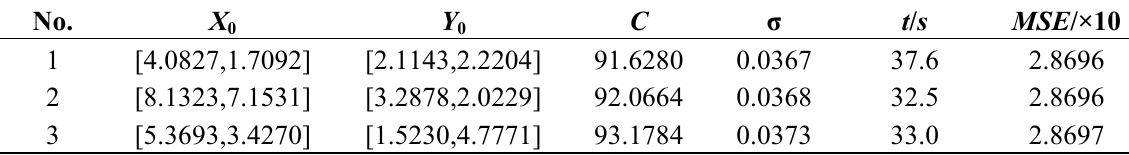
Table 3. Influence of different fruit fly initial